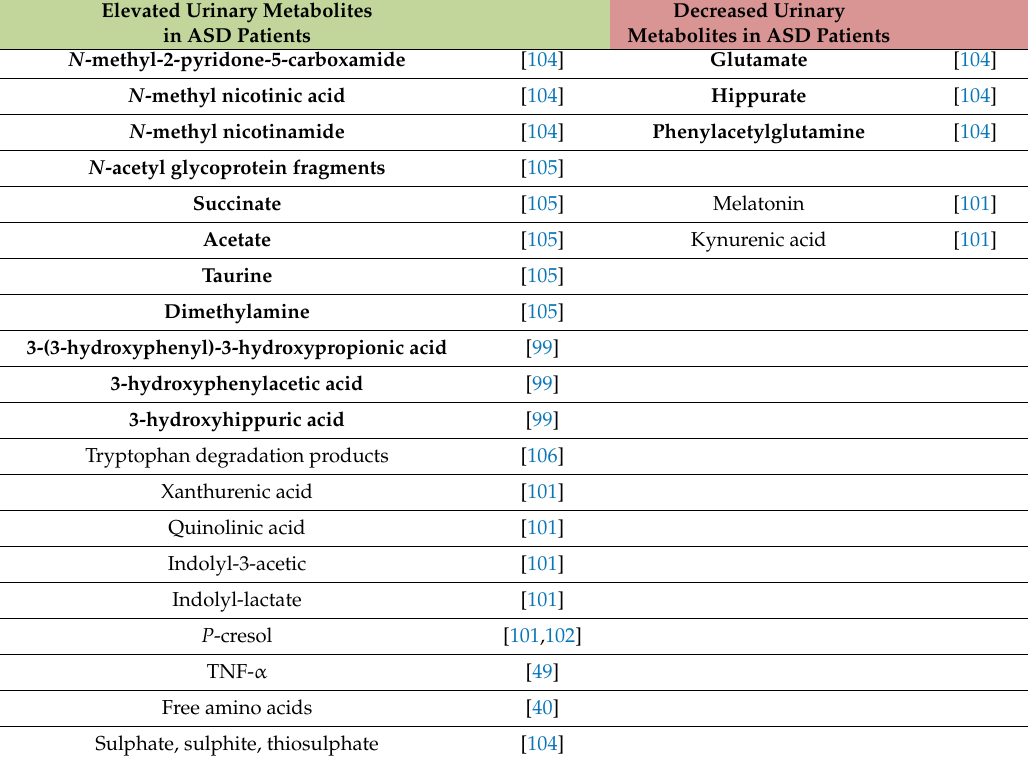
Table 1. Elevated and decreased metabolites in the urinary profiles of ASD children. Significant results are written in